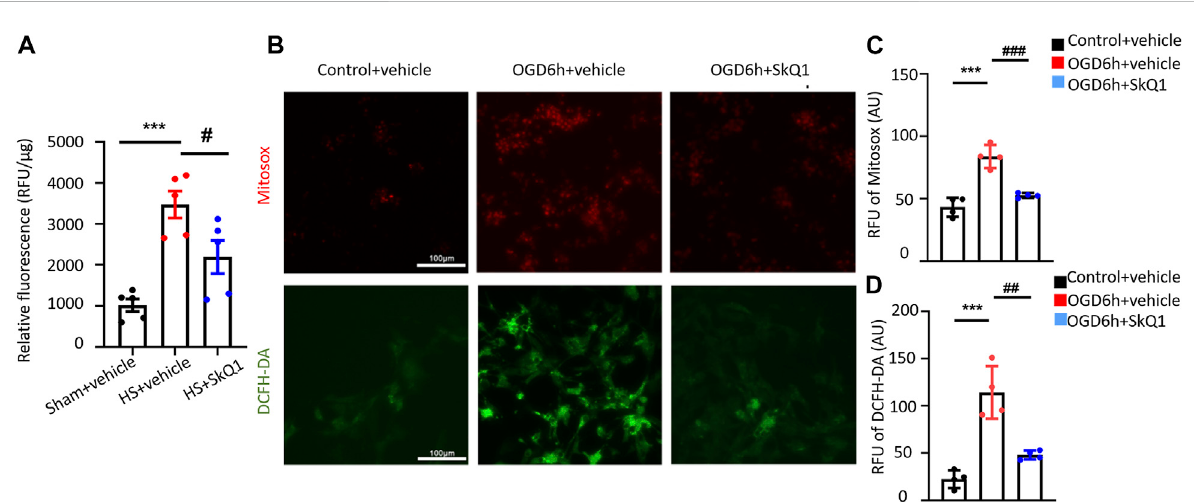
FIGURE 3 SkQ1 attenuates the increased ROS induced by HS in myocardial tissues and by oxygen-glucose deprivation in cardiomyocytes. (A) Statistical relative fl uorescenceunits(RFU)ofthemyocardialROSlevelsinthesham,HS+vehicleandHS+SkQ1groups. n =5micepergroup;*** p < 0.001vs. the sham; and # p < 0.05 vs. HS + vehicle. (B) Representative images of ROS fl uorescence staining of neonatal rat cardiomyocytes from thecontrol + vehicle, OGD 6 h + vehicle, and OGD 6 h + SkQ1 group. MitoSOX was used to label mitochondrial ROS (red fl uorescence), and DCFH-DA